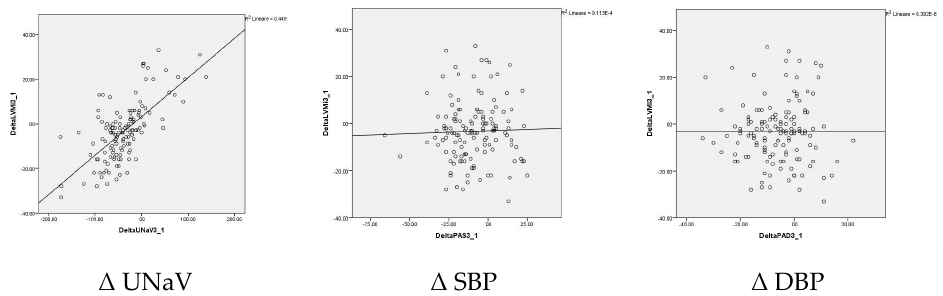
Figure 4. The graphical representation is reported as an example for simple linear regressions ( Δ LVMI vs. Δ UNaV, Δ SBP, and Δ DBP, respectively).